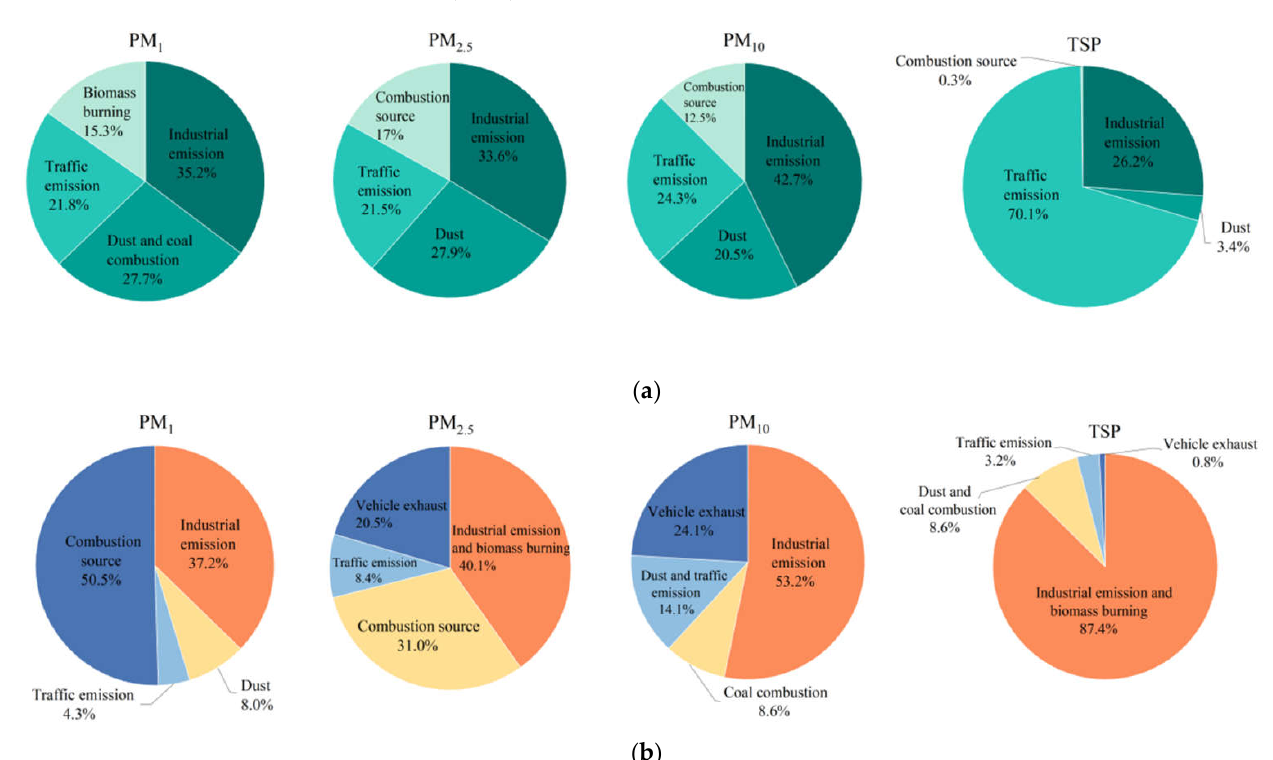
Figure 4. Source apportionment of PM 1 , PM 2.5 , PM 10 and TSP during the ( a ) non-sandstorm and ( b ) sandstorm.